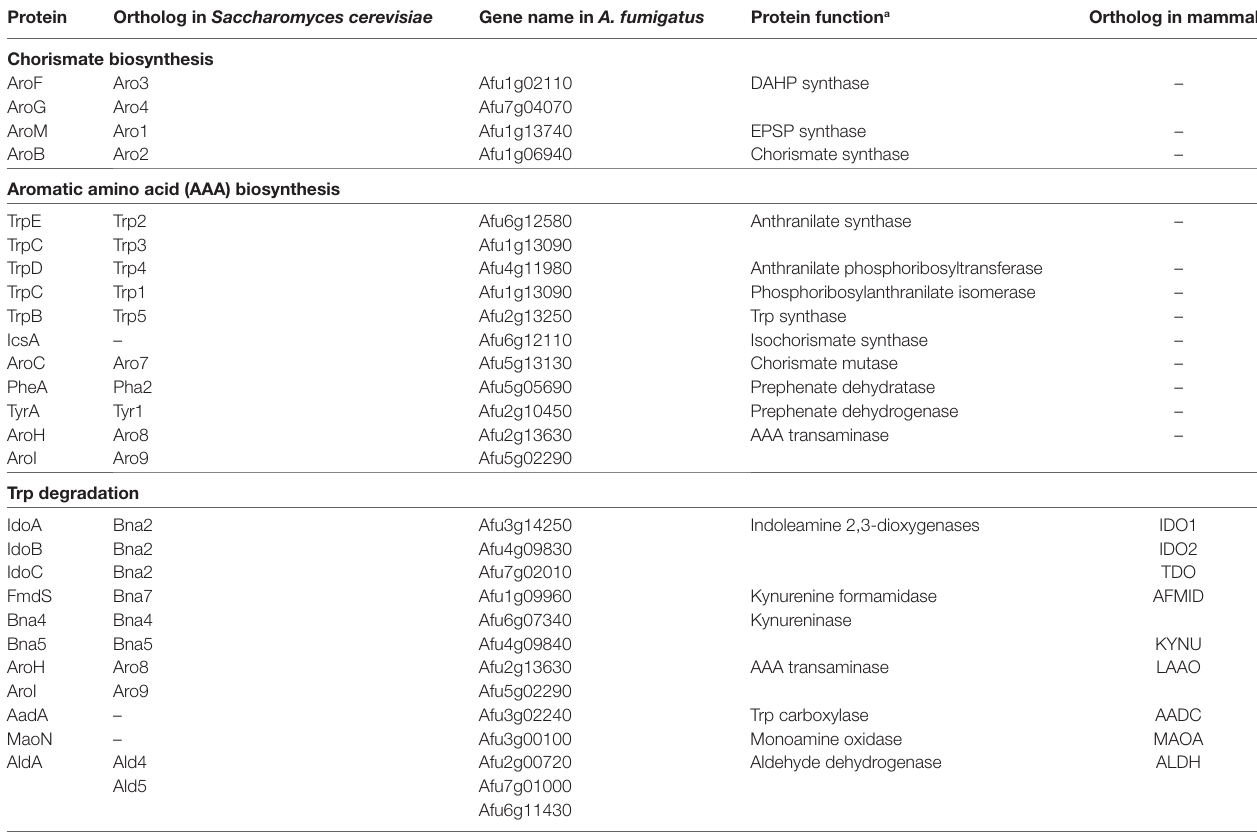
TAble 2 | Aspergillus fumigatus tryptophan (Trp) metabolism genes and putative protein function.